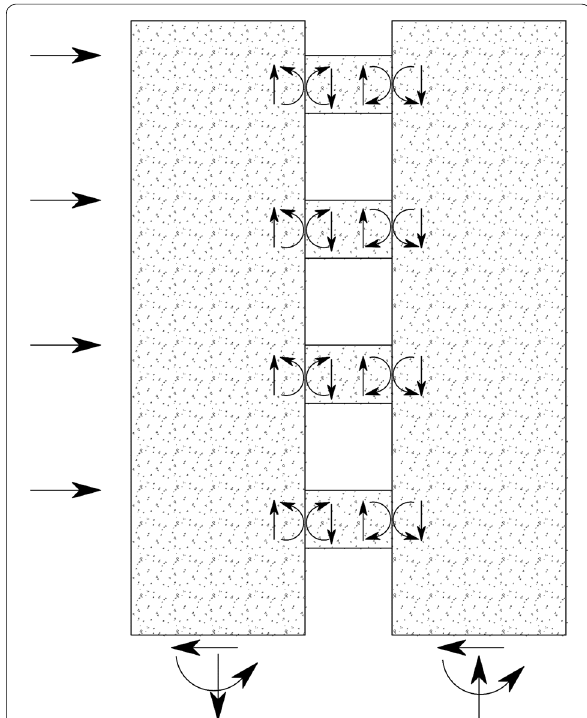
Fig. 1 The diagram of RC coupled wall systems subjected to lateral